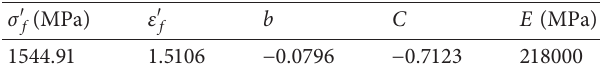
Table 4: The fatigue performance parameters of 40Cr